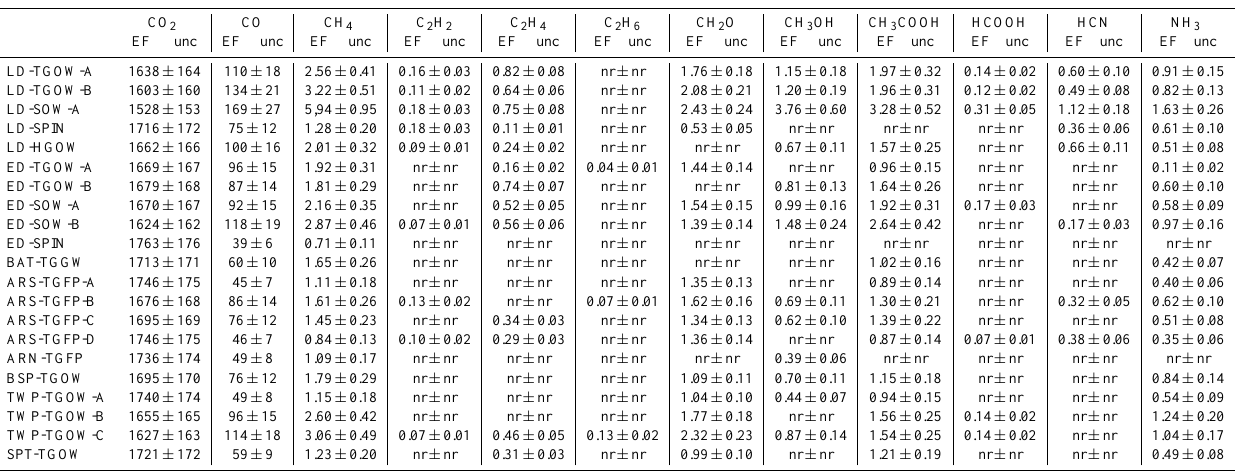
Table 4. Emission factors (gkg − 1 of dry fuel burned) for each individual fire, calculated using the standardised method outlined in Paton- Walsh et al. (2014). Uncertainties were calculated in quadrature from those associated with the trace gas emission ratios and a ± 10% uncertainty in the assumed fuel carbon.